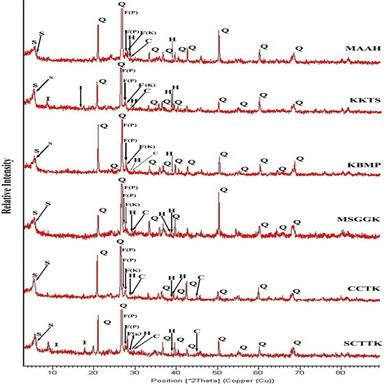
Mineralogical compositions of monumental brick samples. The Peaks correspond to each identified crystalline phases: Q-quartz, I- illite, S-smectite, H-hematite, F (P) - Plagioclase feldspar, F (K)-K-feldspar, and C-calcite.